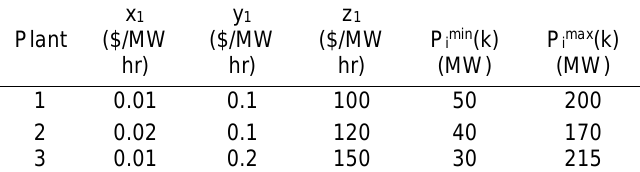
Table 1. Generation cost for thermal